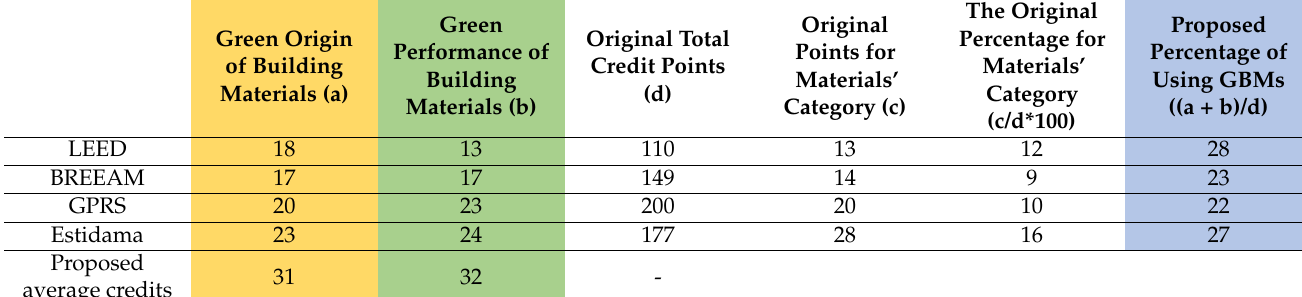
Table 4. Comparison between GBMs credits for the proposed assessment criteria among Green Building rating systems. Green